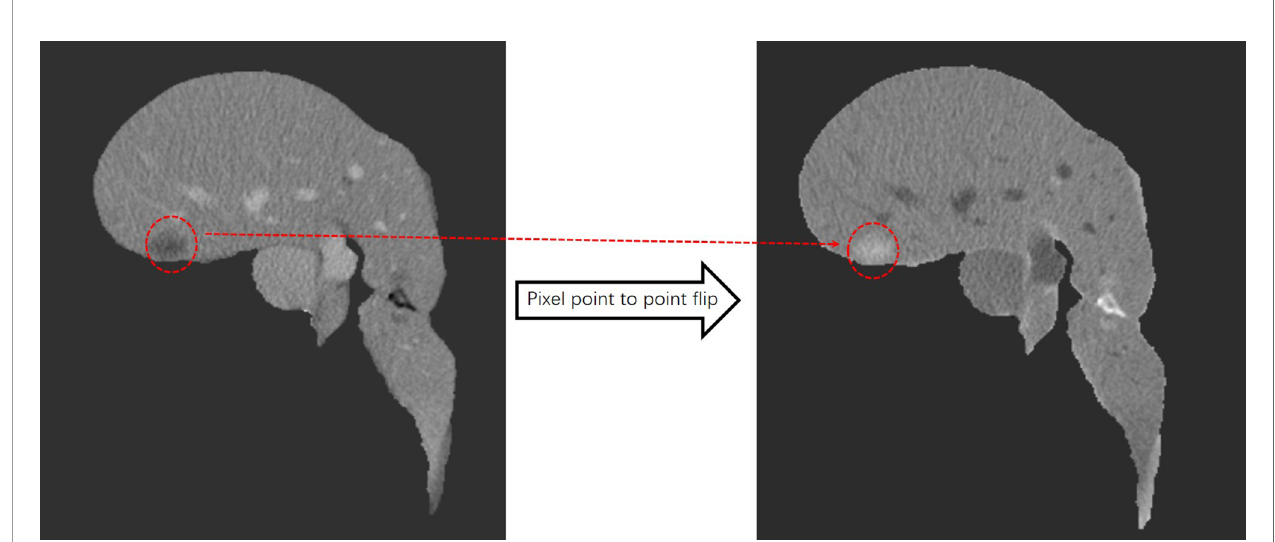
FIGURE 3 | After pixel point-to-point fl ipping, the liver turns gray, the tumor turns white, and the area outside the liver is black.